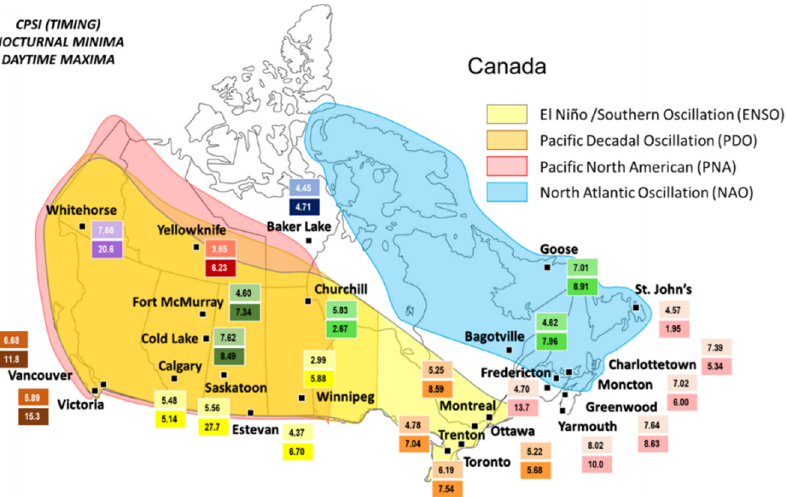
Figure 13. The CPSI of Diurnal Extrema Timing (DET) for minima ( upper row values ) and maxima ( lower row values ) indices of study locations within the range of Canadian climatic patterns. The map of Canada with regions impacted by large climatic patterns (Adapted from Large-Scale Climate Oscillations Influencing Canada, 1900-2008 by Bonsal and Shabbar, 2011. Copyright 2011 by Her Majesty the Queen in Right of Canada).